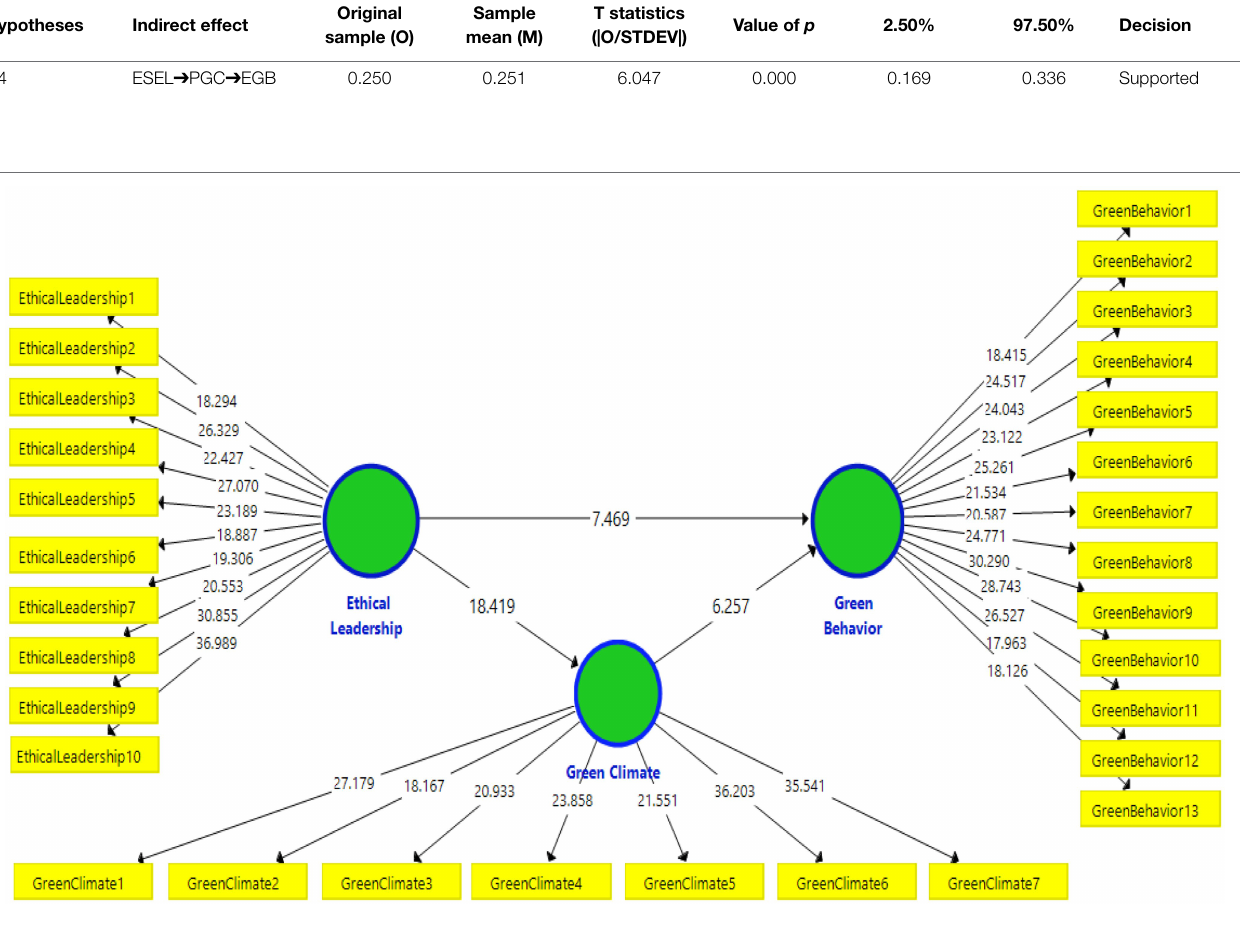
FIGURE 5 | PLS Bootstrapping results for the structural